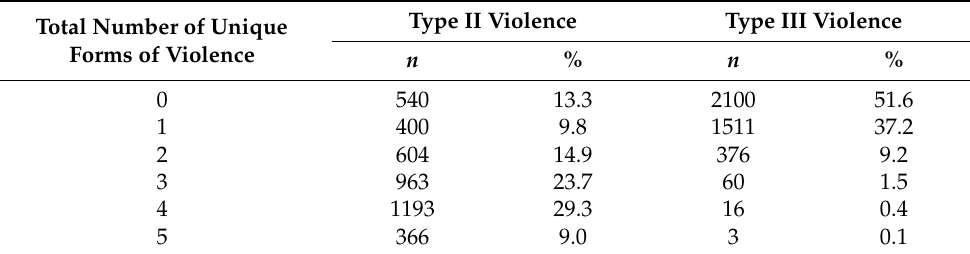
Table 2. Descriptive statistics of nurse exposure to total number of unique forms of Type II and III violence ( n = 4066). Total Number of